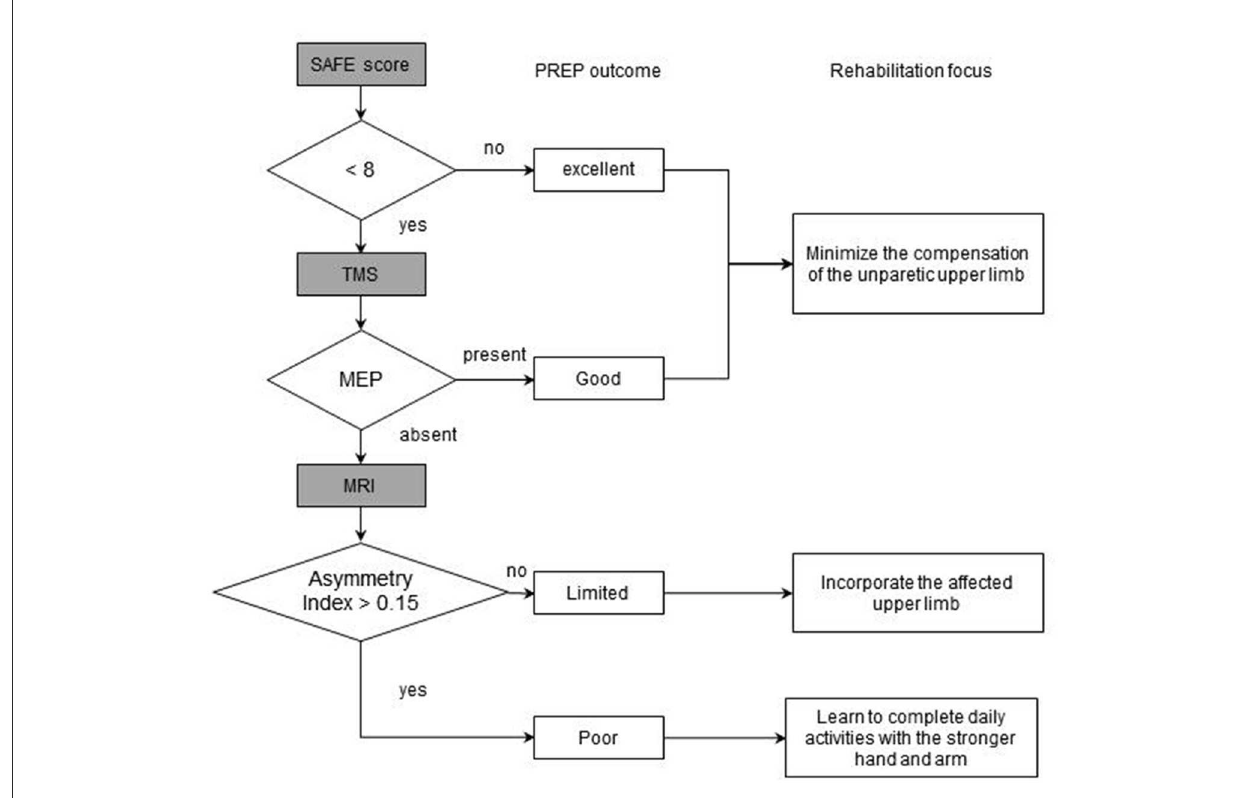
FIGURE1 The flowchart of PREP model.